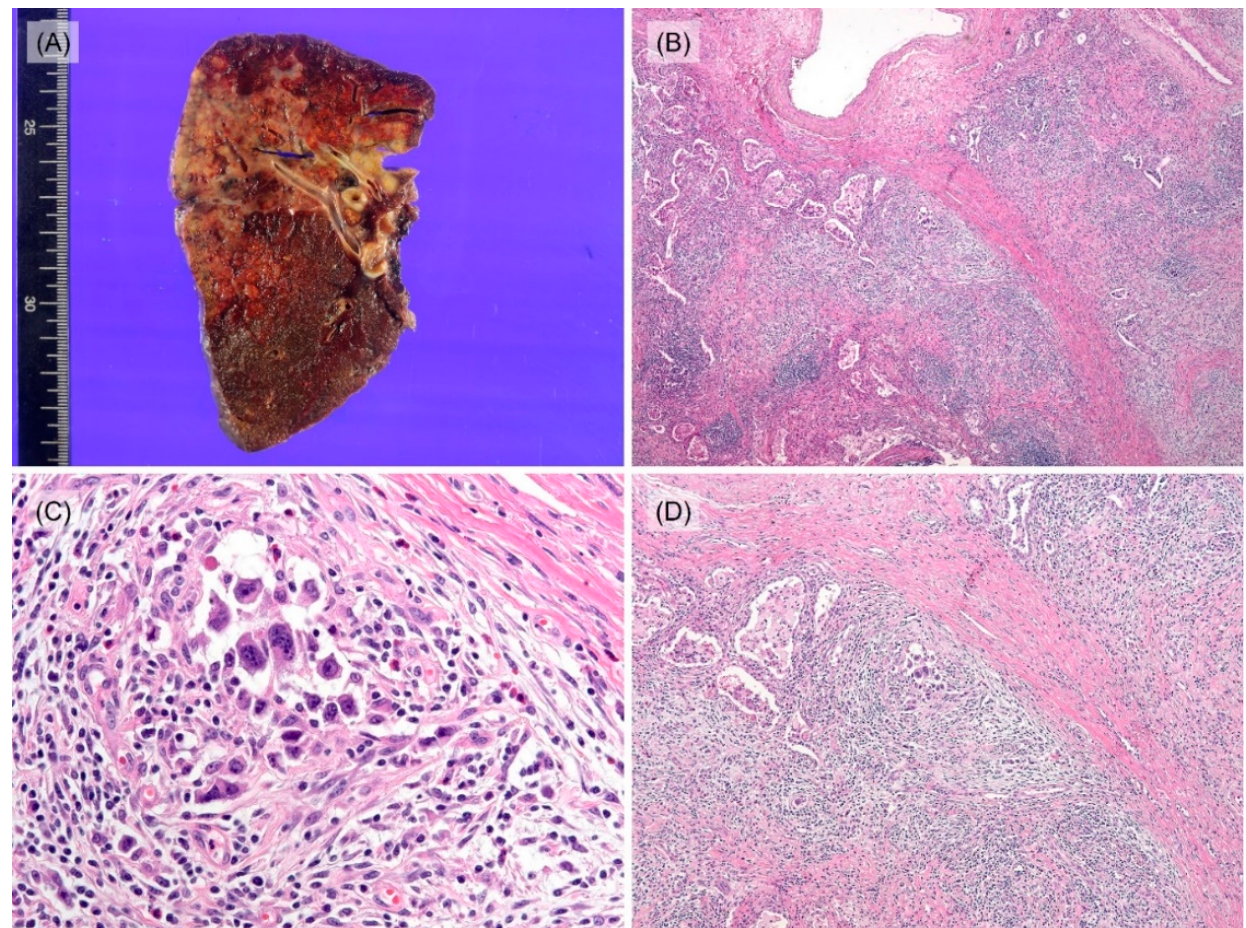
Figure 3. Gross and histologic features of resected specimen (case 9). ( A ) Gross finding of right upper lobectomy specimen shows multiple yellowish nodules with septation. ( B ) Some reactive epithelial cells in the inflammatory background are showing moderate atypia; thus, it is difficult to distinguish between epithelial malignancy and PPHL (40 × ). ( C ) Hodgkin cells in the inflammatory background (400 × ). ( D ) Activated pneumocytes in peripheral area (100 × ).